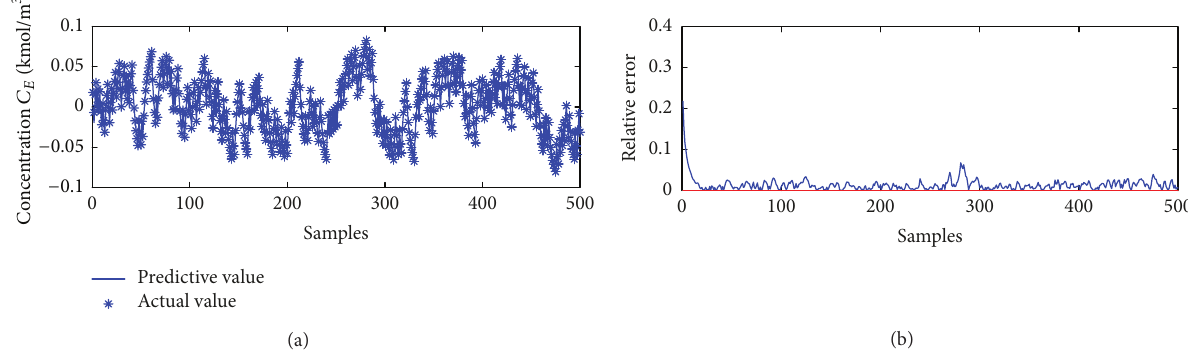
Figure 4: Biodiesel concentration prediction result and relative error under reactor flow rate 𝐹 𝑜 action.